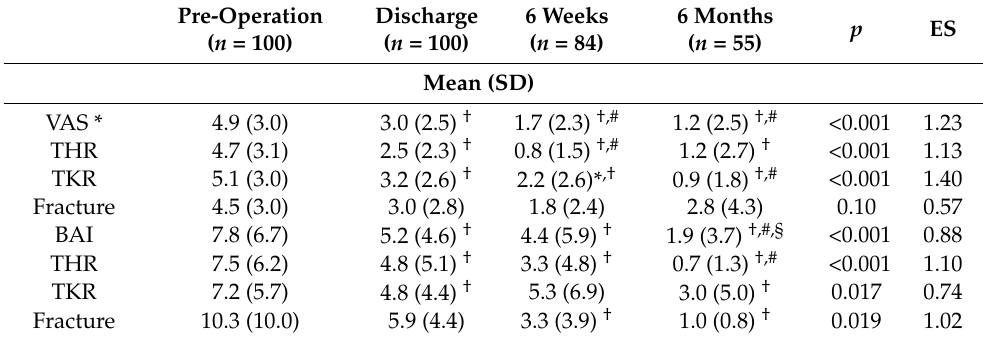
Table 3. The VAS and BAI at pre-operation, discharge, and 6-week and 6-month follow-up.